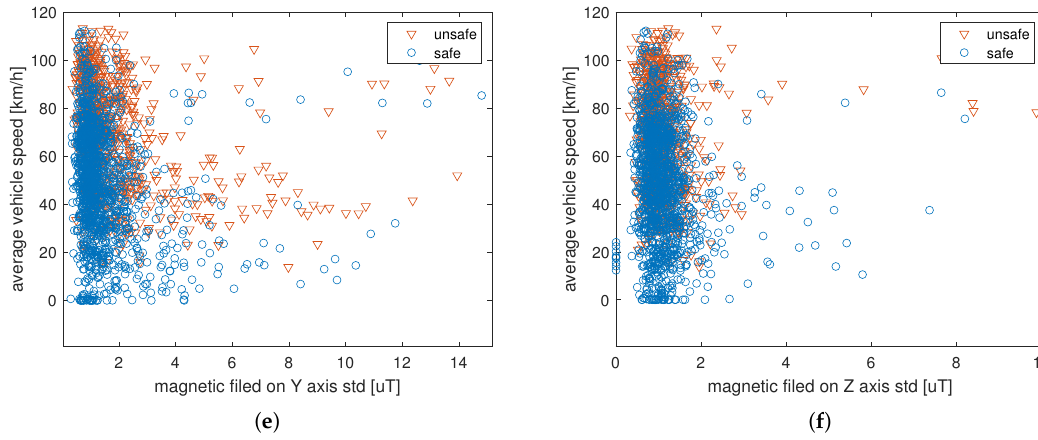
Figure 6. Scatter plots of several features calculated starting from the dataset